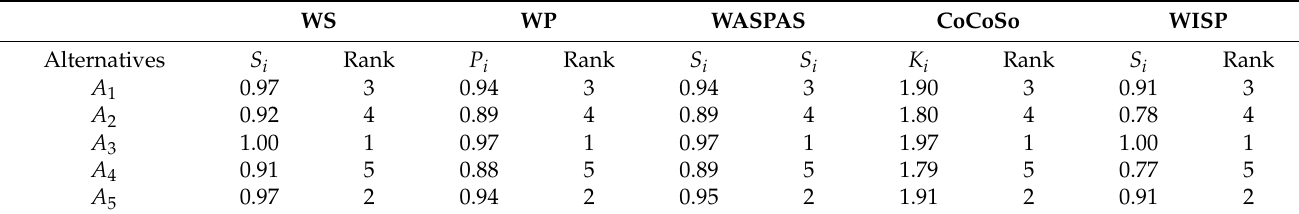
Table 14. Ranking of alternatives on the basis of 50 virtual respondents and crisp approach.